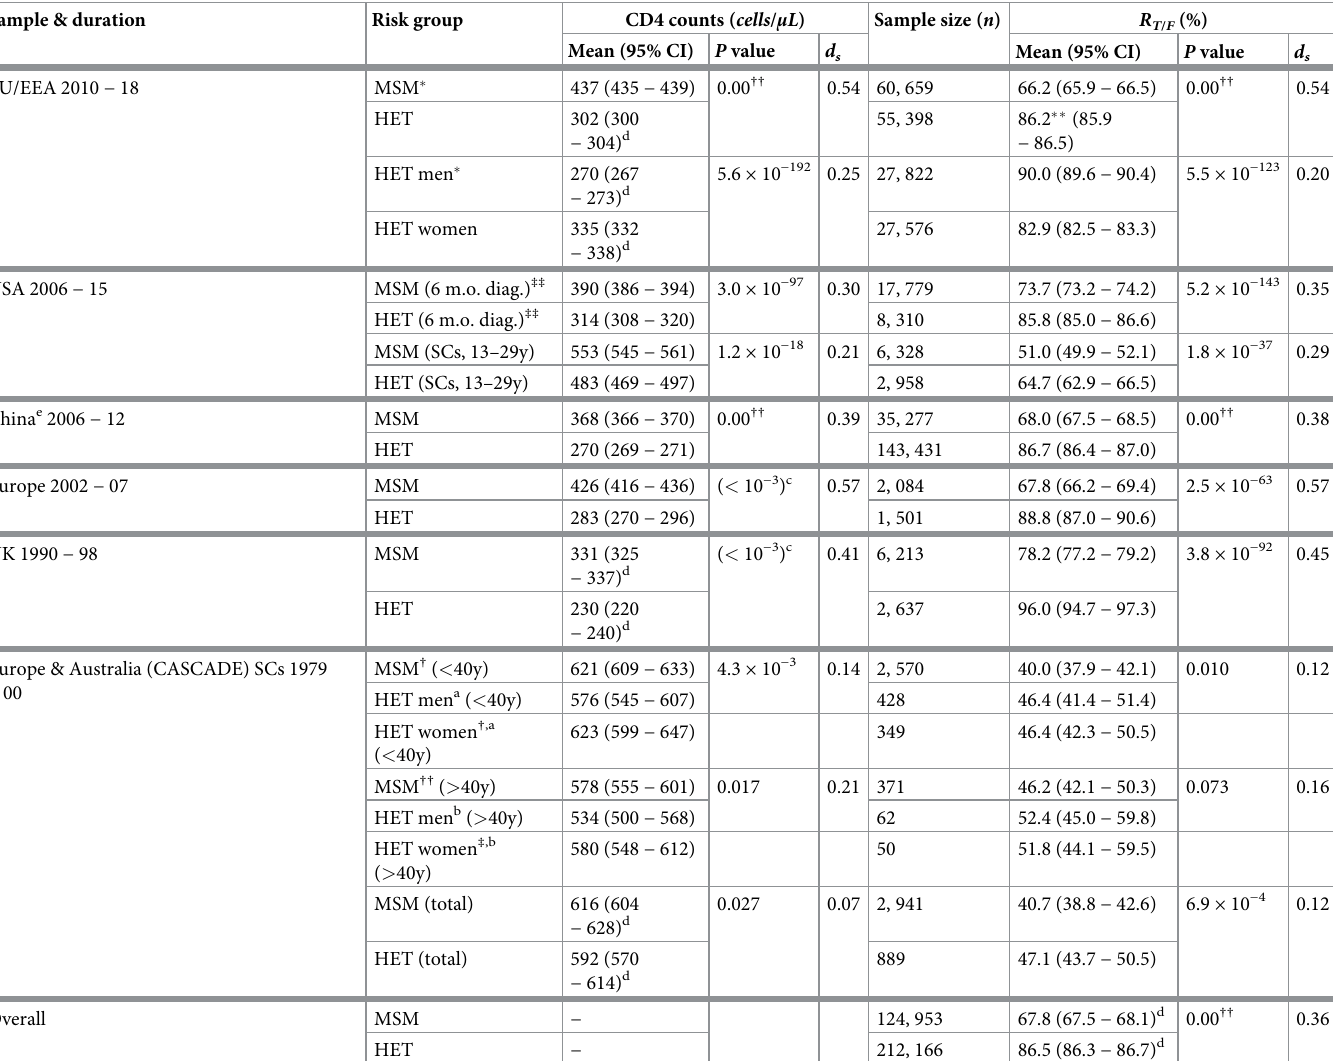
Table 1. Early CD4 cell counts and R T / F in infected adults at diagnosis or seroconversion. P values and Cohen’s d values ( d s ) for comparisons of the CD4 counts and R T / F between MSM and HET are also shown. The last row represents the population-weighted average of all the datasets. (See text and S3–S6 Tables for details and data